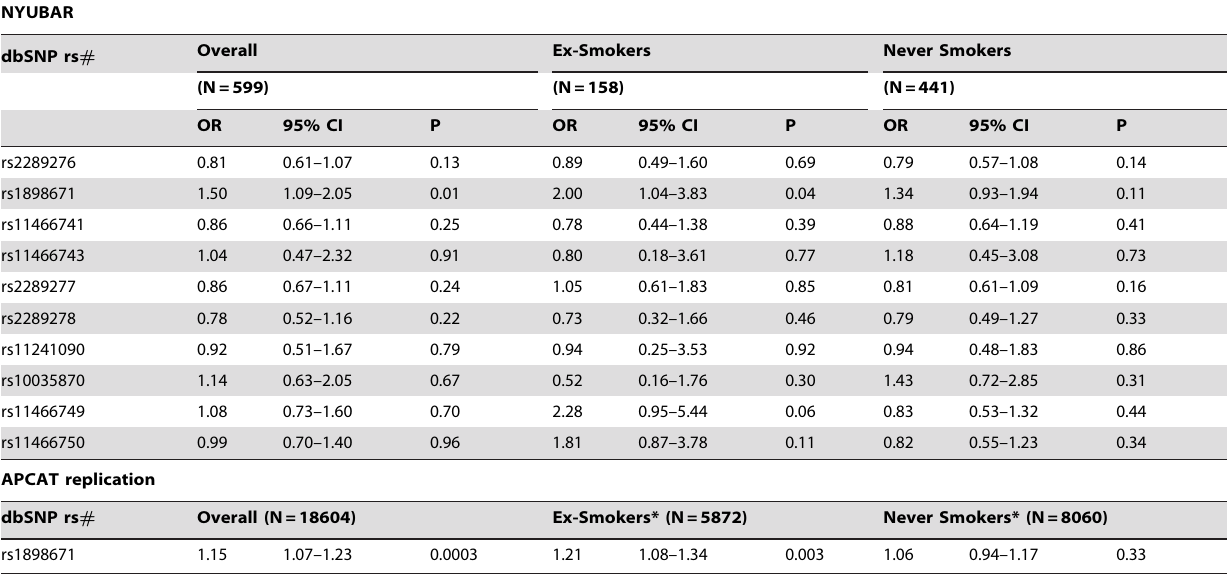
Table 2. Results of association analysis of asthma with TSLP SNPs.